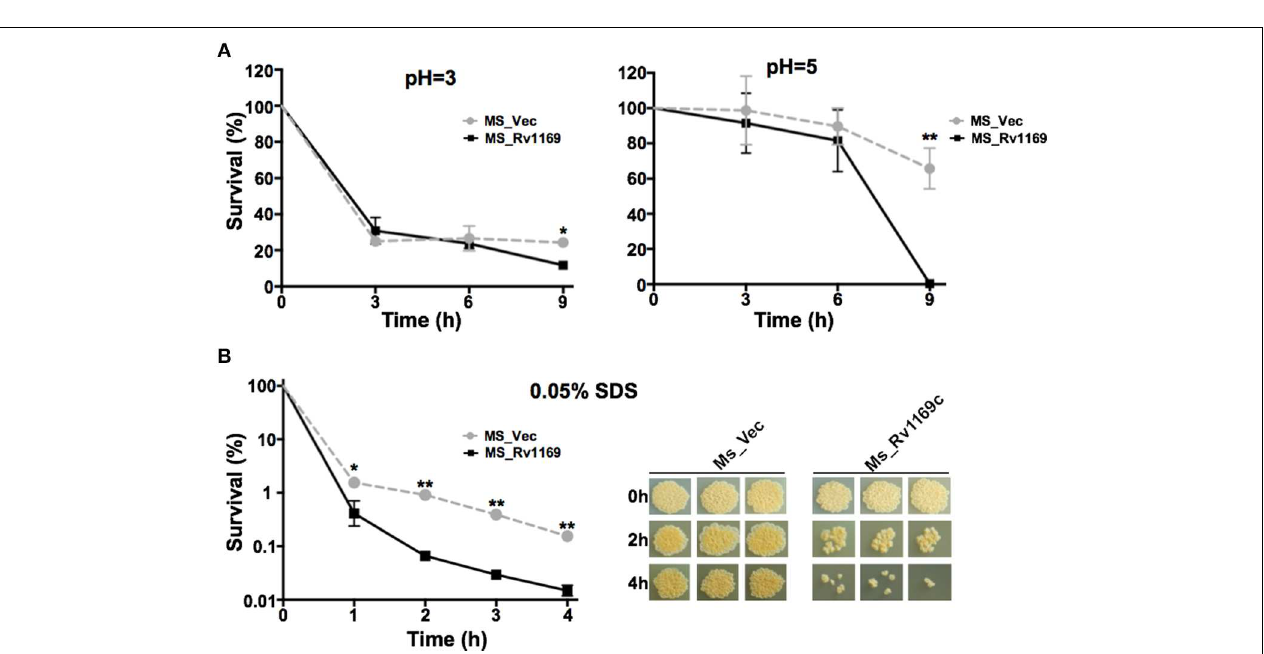
containing Hyg. (B) Survival of Ms_Vec and Ms_Rv1169c after exposure to 0.05% SDS. Re-suspended 5ml recombinant MS_Vec and MS_Rv1169c ( OD 600 = 0 . 5 ) were exposed to 0.05% SDS for 1, 2, 3, and 4h. And then the recombinant strains were plated onto 7H10 plates by serially ten-fold dilution, the bacterial numbers were counted after 3–4 days of cultivation at 37 ◦ C. * P < 0 . 05 and ** P < 0 . 01